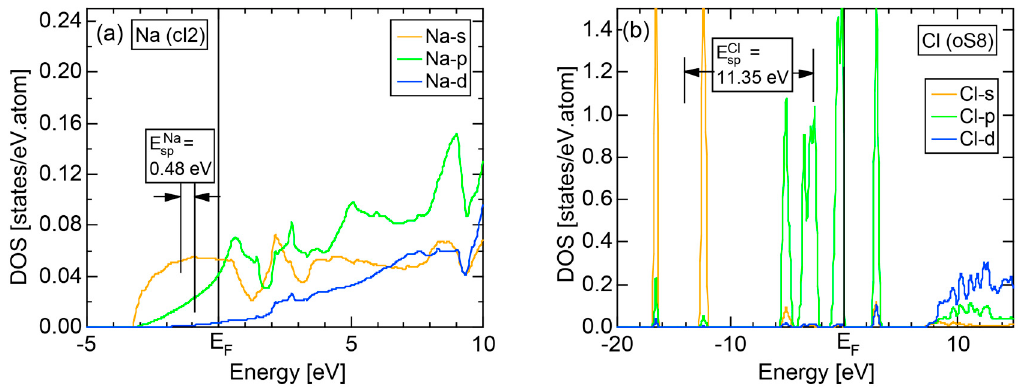
Figure 28. ( a ) Na-partial DOSs and its separation energy E for bcc Na (cI2) and ( b ) Cl- ≡ E − E ( b ) Cl-partial DOSs and its separation energy E sp for orthorhombic Cl (oS8) [11,12]. sp s p E sp for orthorhombic Cl (oS8) [11,12]. partial DOSs and its separation energy (cid:12) (cid:12) The data of (cid:12) E 3 s − E 3 p (cid:12) for elemental solids in Period 3 in normal conditions are also The data of E − E 3 s 3 p